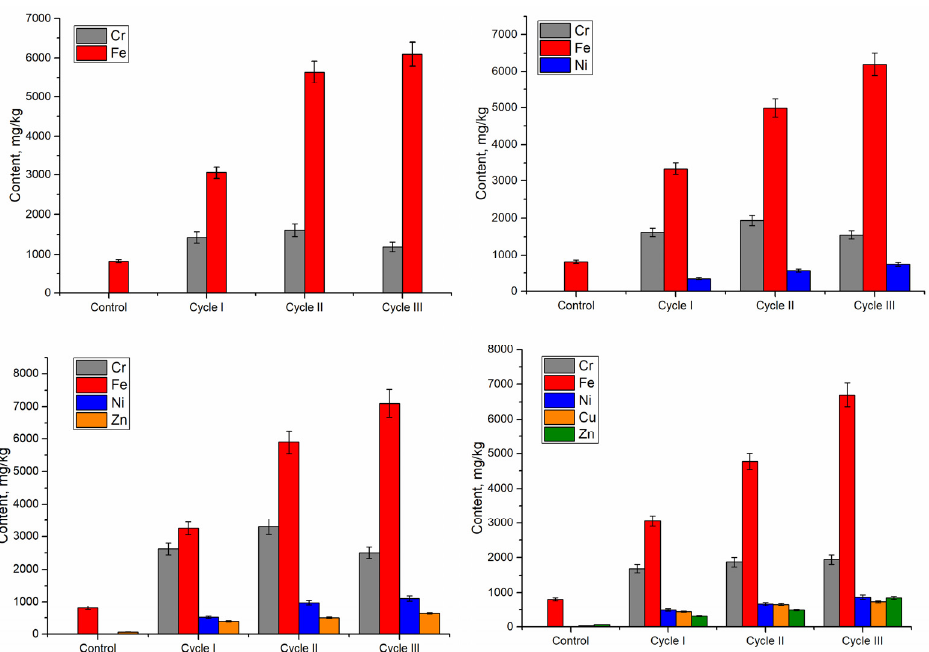
Figure 2. Bioaccumulation of chromium and other metals by Nostoc linckia biomass during 3 life cycles on media containing multi-metallic systems .